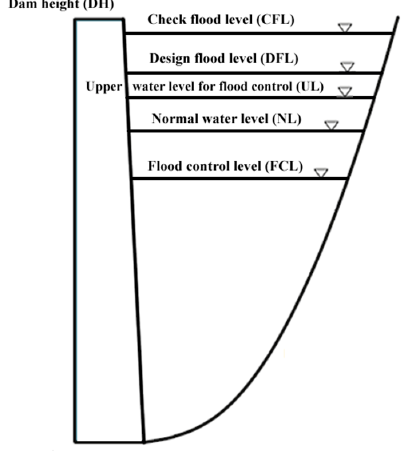
Figure 1. The sketch map of key water levels. Table 5. Definition of dam type indicator (DTI) and damage rating factor (DRF) a (from [10]). Type of Dam